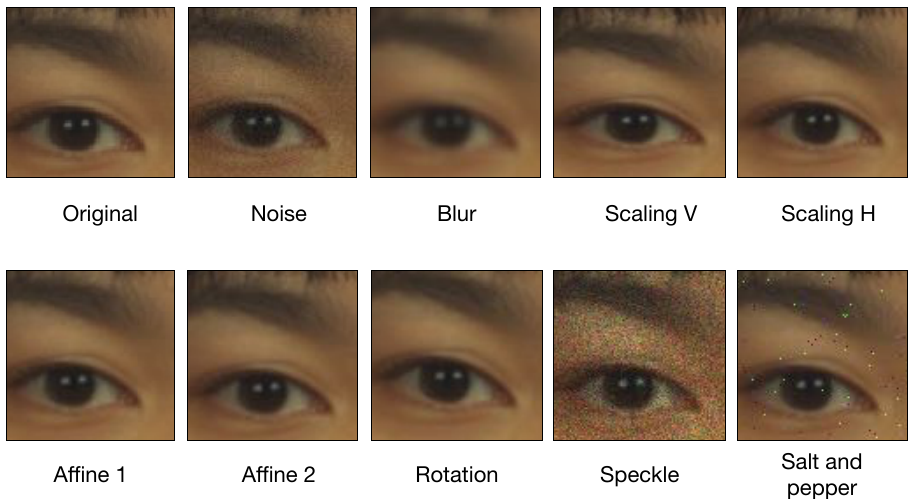
Figure 11. Example of processed electronic Machine Readable Travel Documents (eMRTD) pictures with different